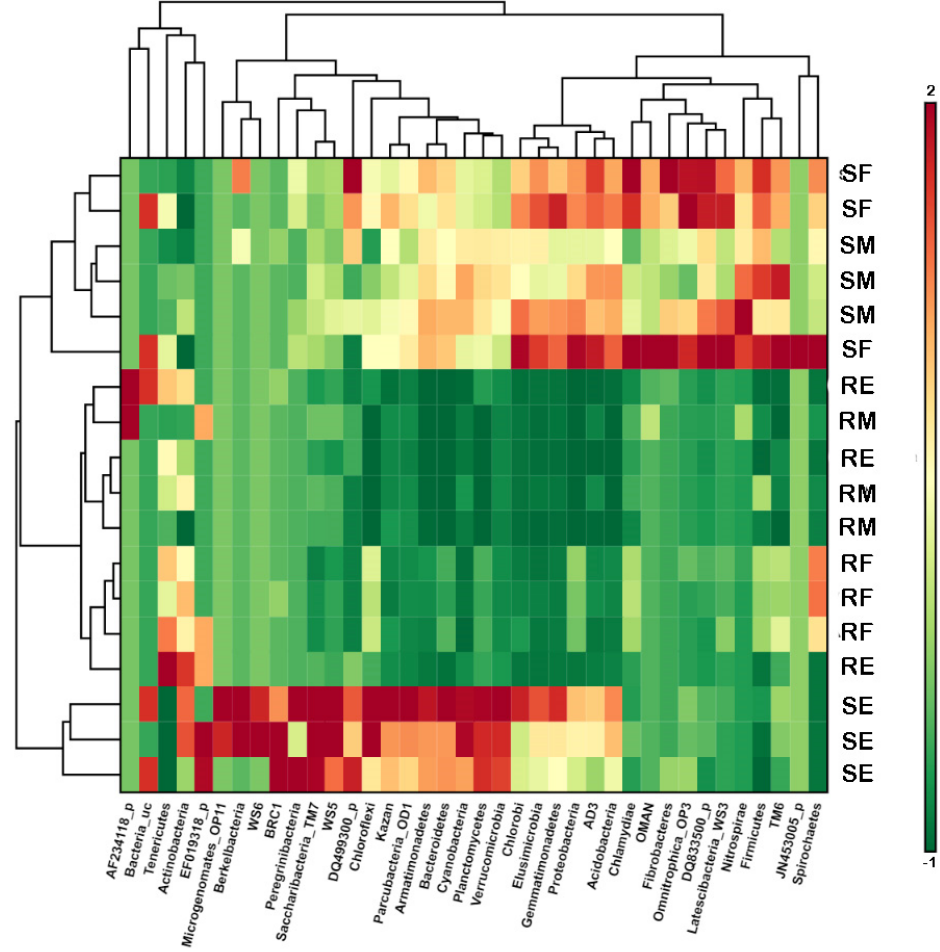
Figure 2. Standardized abundance of different phyla in each sample using hierarchical clustering by Euclidean linkage as parameters. Green colors indicate reduction in abundance and red colors indicate increase in abundance with respect to normalized abundance of each phylum.